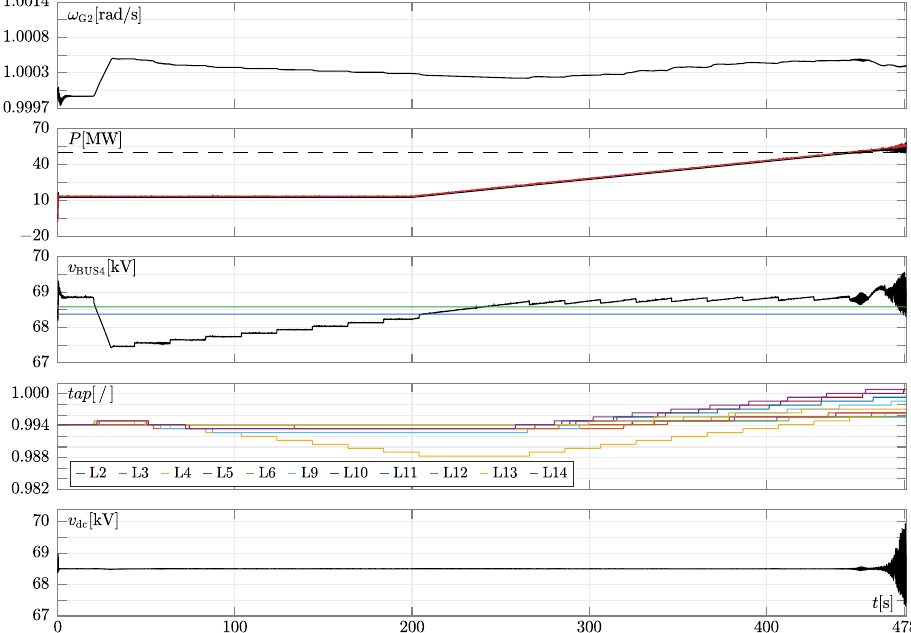
Figure 13. Simulation results of the modified IEEE 14 test system shown in Figure 6 when the line between BUS 2 and BUS 5 is tripped at 4s and the damping of all synchronous generators and condensers were set to 10. MMC , load, line, and transformer models used are the same as those of previous simulations. Analogously to Figure 12, the active power set-point of MMC 1 changes linearly. The second panel from the top: active power exchange of MMC 1 (black trace) and MMC 2 (red trace). The dashed line denotes the active power reference value above which the system becomes unstable (i.e., 50MW). Last panel: pole-to-pole voltage of MMC 1. The traces in the other panels have the same meaning as those in Figure